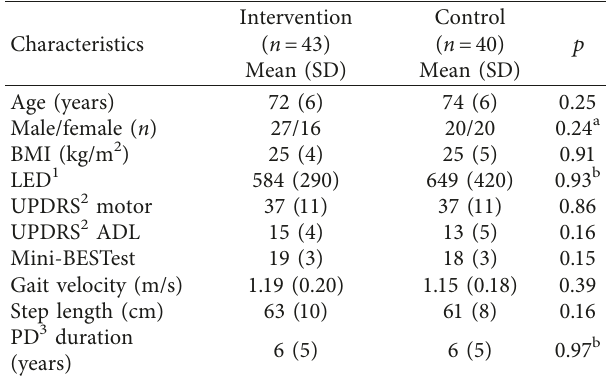
Table 1: Demographics of subjects with valid baseline acceler- ometer data separated by groups.